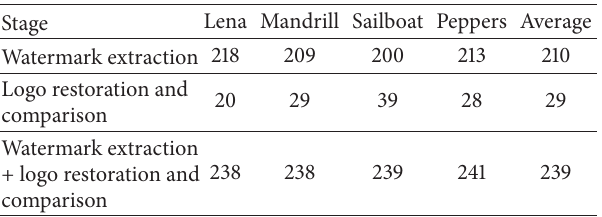
Table 5: The processing time (ms) for watermark extraction and logo restoration and comparison.